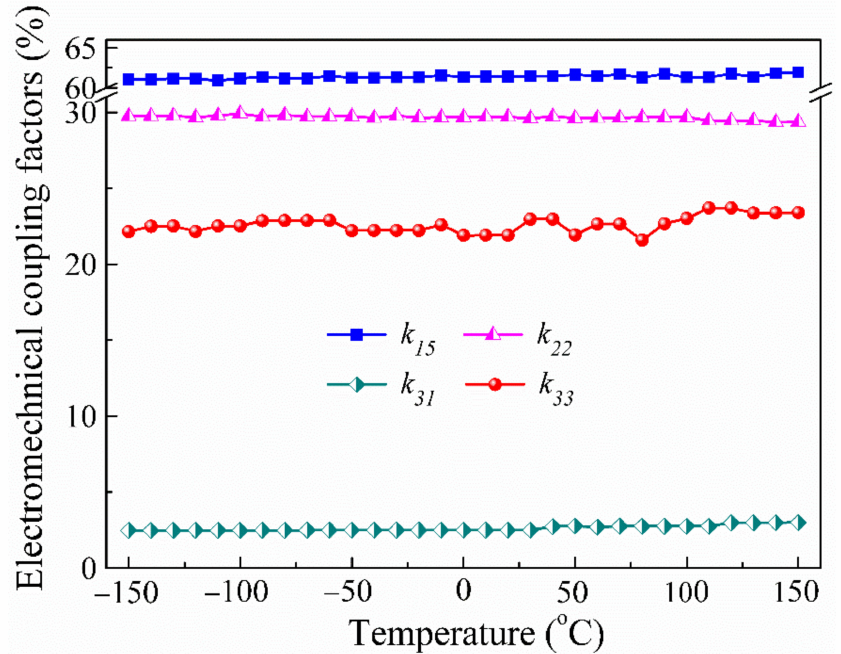
Figure 4. Variation of electromechanical coupling factor k ij for LN crystals.